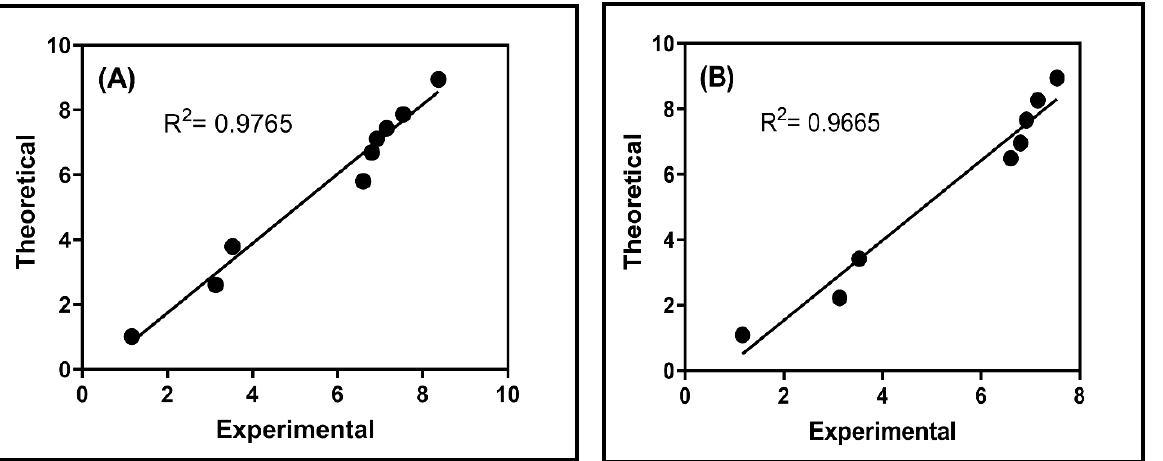
Figure 5. Correlation studies between observed and calculated ( A , B ) 1 H-NMR of conformation S1 and S2 of complex, respectively.